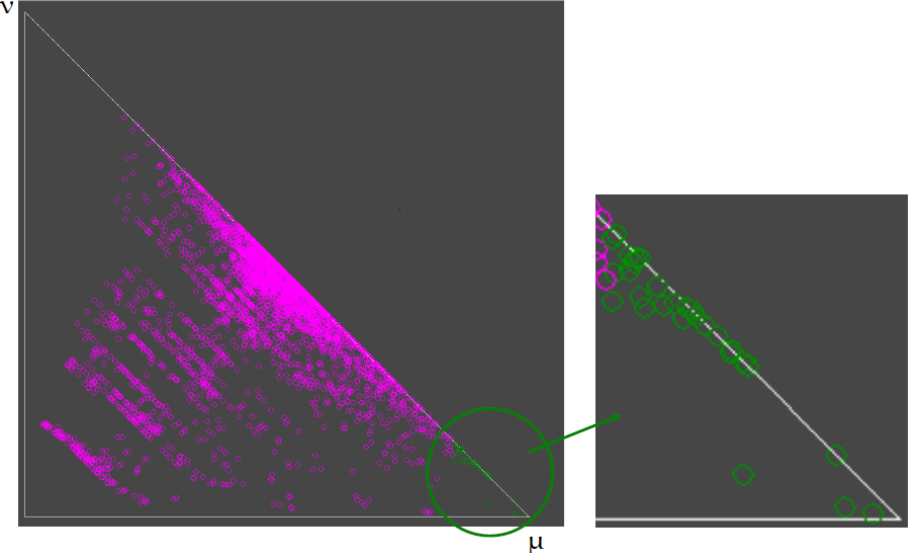
Figure 6. Twenty-nine criteria pairs that show high degree of agreement µ > 0.85, illustrated with green circles.